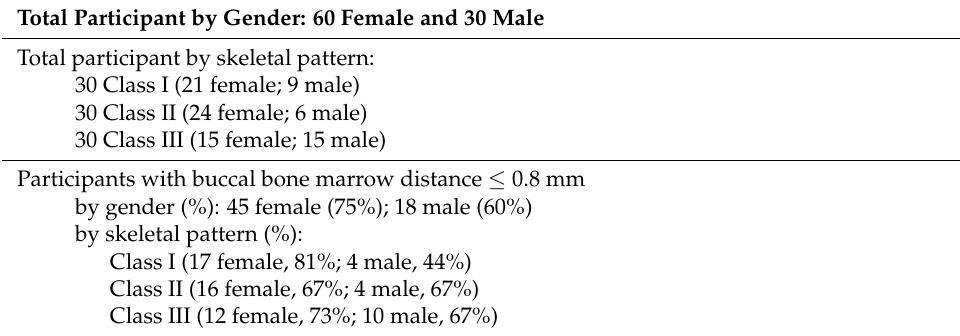
Table 1. The summary of participants’ characteristics. ( n = 90).